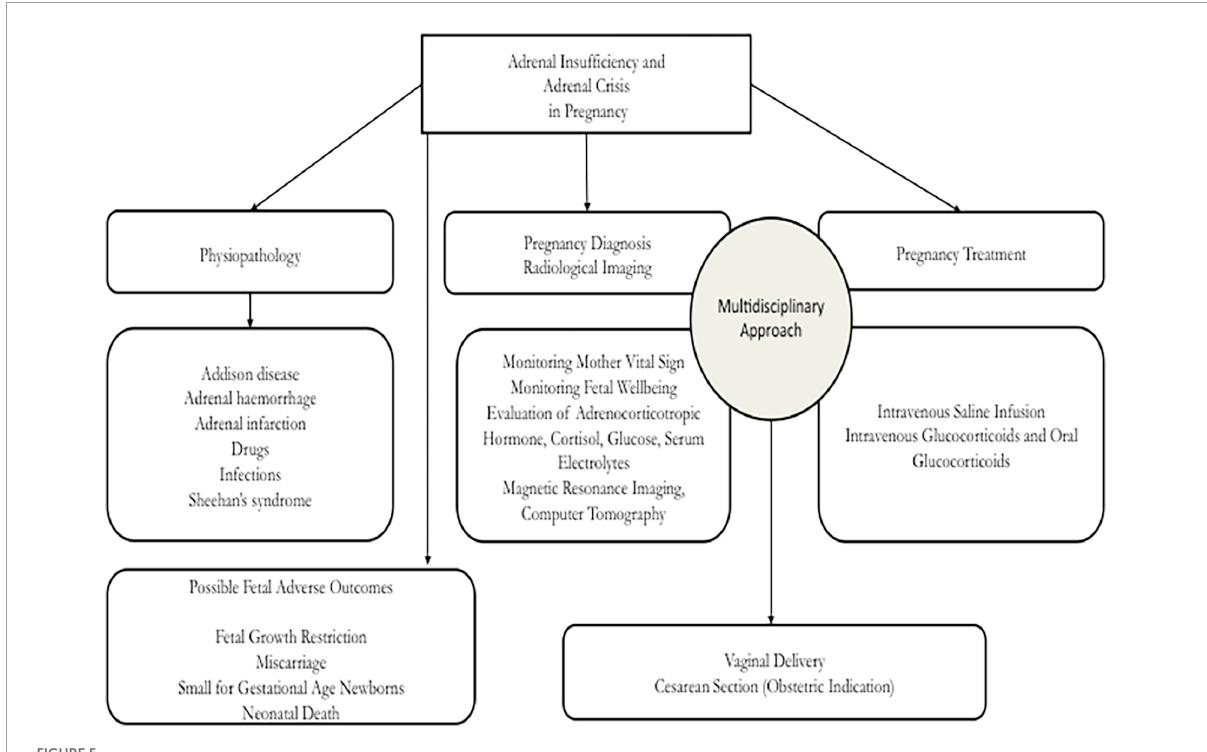
FIGURE5 Flow-chart of management of adrenal crisis in